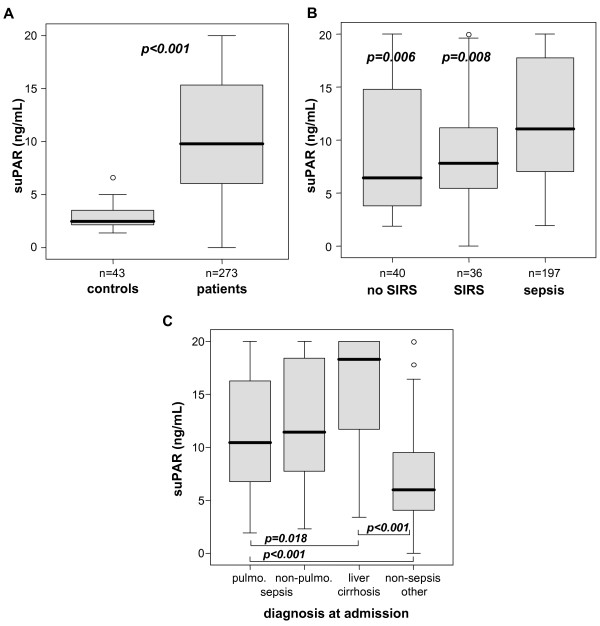
Serum suPAR concentrations in critically ill patients with different disease etiologies at ICU admission. (A) At admission to the Medical ICU, serum suPAR levels were significantly (P < 0.001, U-test) elevated in critically ill patients (n = 273) as compared to healthy controls (n = 43). (B) In comparison to ICU patients without SIRS or with SIRS, septic patients had higher suPAR serum concentrations (U-tests to sepsis group, P-values given in figure). (C) suPAR serum concentrations did not differ in patients with either pulmonary or non-pulmonary origin of sepsis and are highest in patients with decompensated liver cirrhosis.